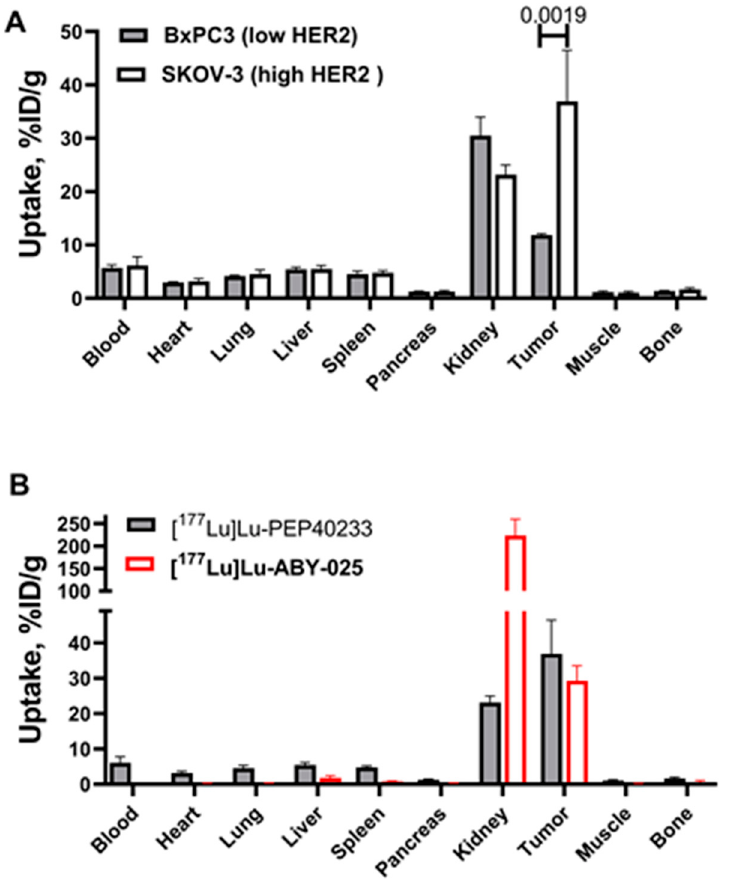
Figure 6. Biodistribution at 48 h post injection. ( A ) Biodistribution of [ 177 Lu]Lu-PEP40233 in BALB/C nu/nu mice bearing SKOV-3 and BxPC3 xenografts. Data are presented as an average value from four mice ± SD. The data show higher accumulation in xenografts with higher HER2 expression. ( B ) Comparison of biodistribution of [ 177 Lu]Lu-PEP40233 and [ 177 Lu]Lu-ABY-025 in SKOV-3 bearing xenografts. Data are presented as an average value from four mice ± SD. The data show clear reduction in the renal uptake and extension of residence in circulation for [ 177